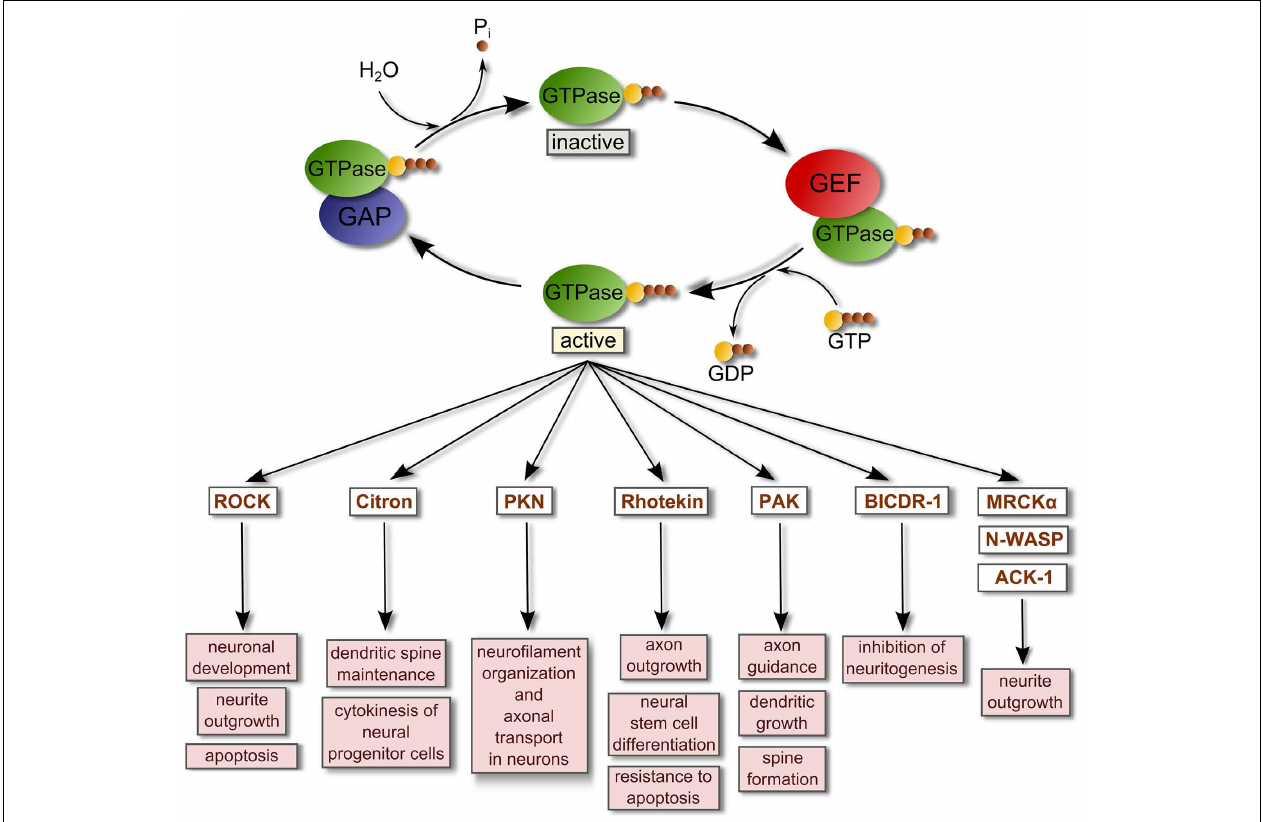
FIGURE 1 | Regulation of small GTPase activity by GEFs and GAPs. Small GTPases are inactive when they are GDP-bound. GEFs bind and stabilize GDP-bound GTPases. However, due to the relatively high concentration of intracellular GTP these complexes rapidly dissociate into GTP-bound GTPases and free GEFs. When they are GTP-bound, GTPases regulate the activity of their binding targets or effectors to promote several cellular responses. GTPase-activating proteins (GAPs) stimulate the intrinsic hydrolytic capacity of Rho GTPases to promote GDP-bound forms, deactivating the GTPases and terminating the signaling. This reaction